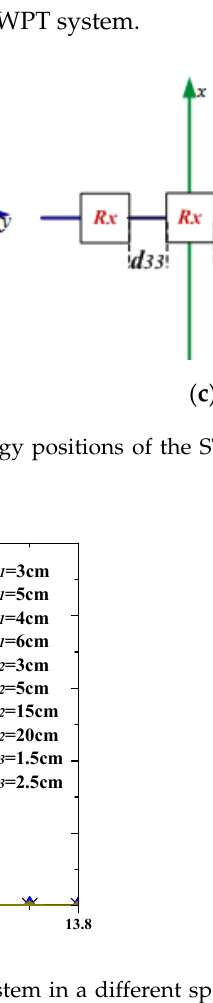
9 of 15 Figure 5. Comparison of the efficiency of the STFR system in different adjacent Rx coils. 3.2. Single Transmitter − Three Receivers (STTR) Figure 6 shows the three possible arrangements for charging devices. The spacing distance of the adjacent Rx coils is labeled as d31, d32 as well as d33 in different cases. The total efficiency of the STTR WPT system in these three cases is presented in Figure 7. It